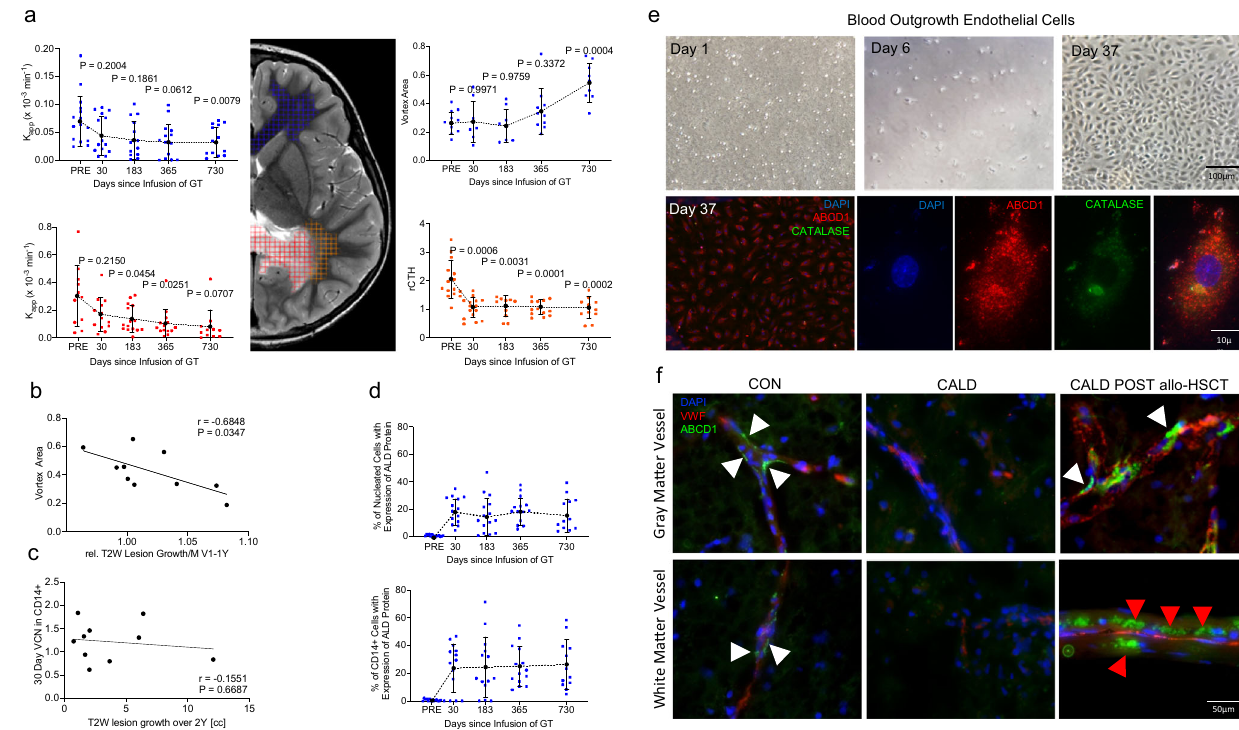
Fig. 4 | Engraftment of Bone-marrow Derived ABCD1 Suf fi cient Cells into the BrainVasculature.a Longitudinalmean K app andmeanVAindistantNAWM(blue), mean K app in the lesion (red) and mean perilesional rCTH (orange) following gene therapy(GT, n =7 – 15eachtimepoint).Blackdotsindicategroupedmean,errorbars indicate SD. Mixed effects analysis with Geisser-Greenhouse correction, a single pooled variance and P values (vs. PRE) adjusted for multiplicity. b Correlation plot showing post treatment VA in NAWM vs. relative monthly T2w lesion growth V1-1Y ( n =10). Line indicates regression; two-tailed Pearson ’ s correlation. c Plot showing the relationship of VCN in CD14+ at 30 days and T2W lesion growth over two years (n=10, simple linear regression). d Longitudinal data on percentage of CD14+ and nucleated cells expressing ALD protein in the peripheral blood after infusion of GT ( n =15). Dotted line connects means; error bars indicate SD. e In vitro Blood out- growthendothelialcellmorphologyafterGTatday1,6and37fromapatientwithat